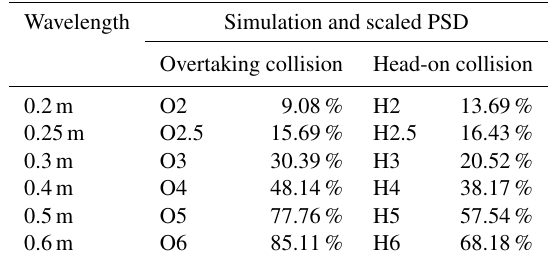
Table 3. Quantitative measurement of the maximum values plotted in Fig. 14. Wavelength Simulation and scaled PSD